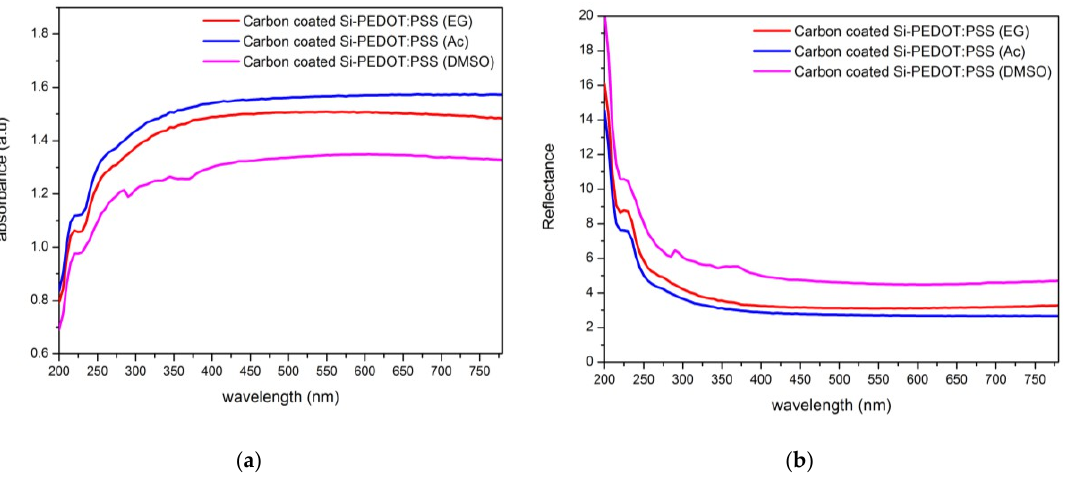
Figure 2. ( a ) Absorption and ( b ) reflectance spectra carbon coated N-type Si wafer with PEDOT: PSS prepared in different solvents (EG) ethylene glycol, (AC) acetonitrile, and (DMSO) dimethyl sulphoxide. Table 1. Optical properties of Si-PEDOT: PSS and carbon coated Si-PEDOT: PSS